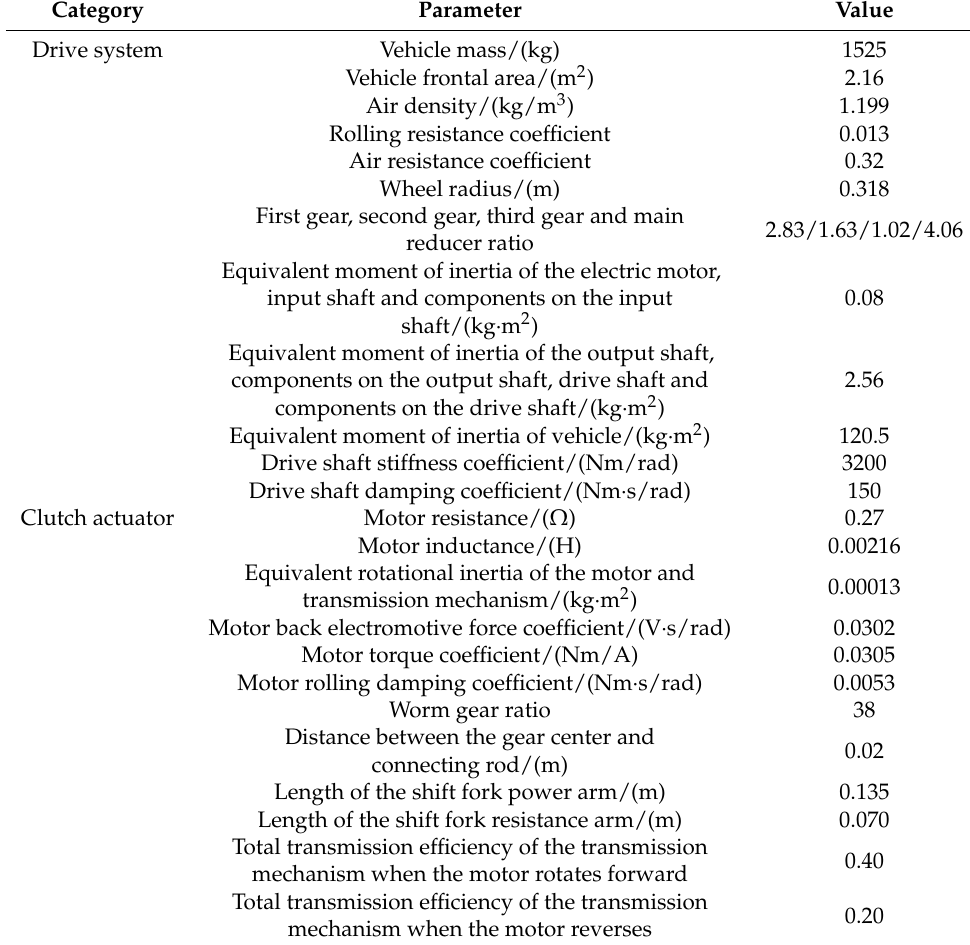
Table 1. Main parameters of the drive system and clutch